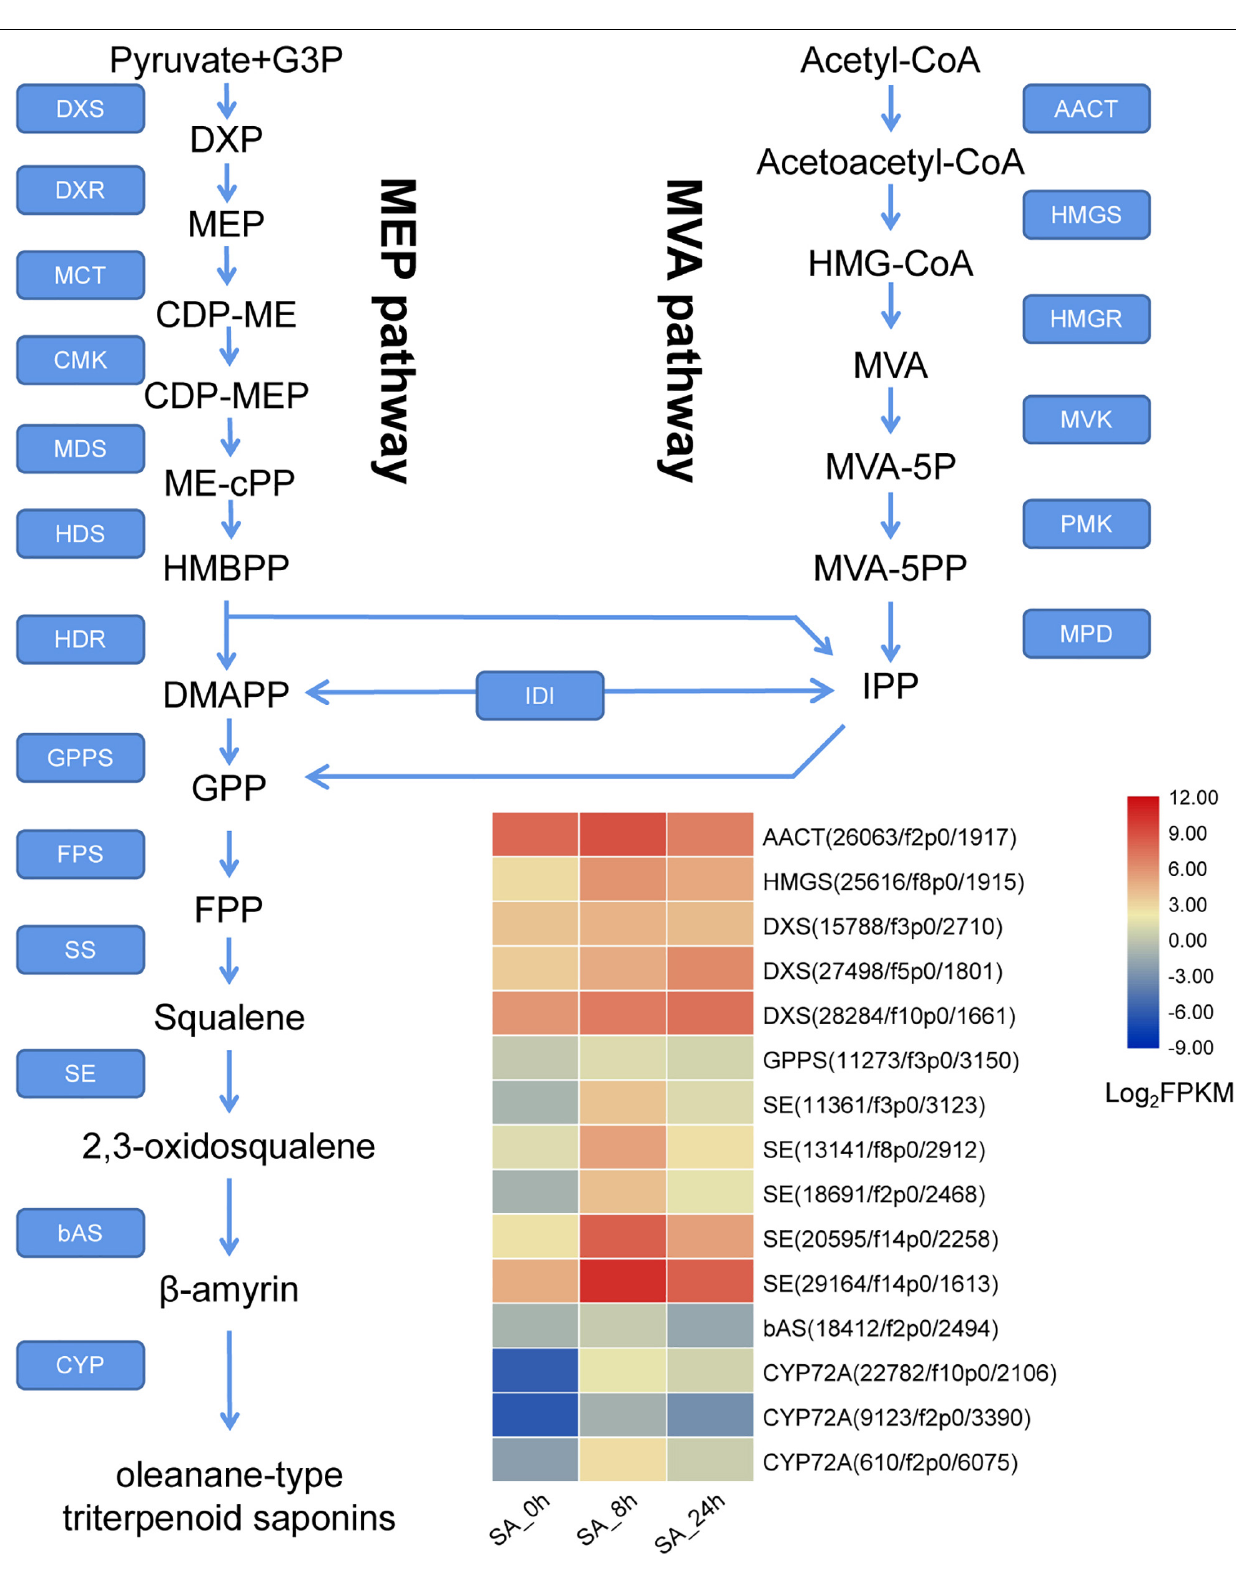
Frontiers in Genetics |